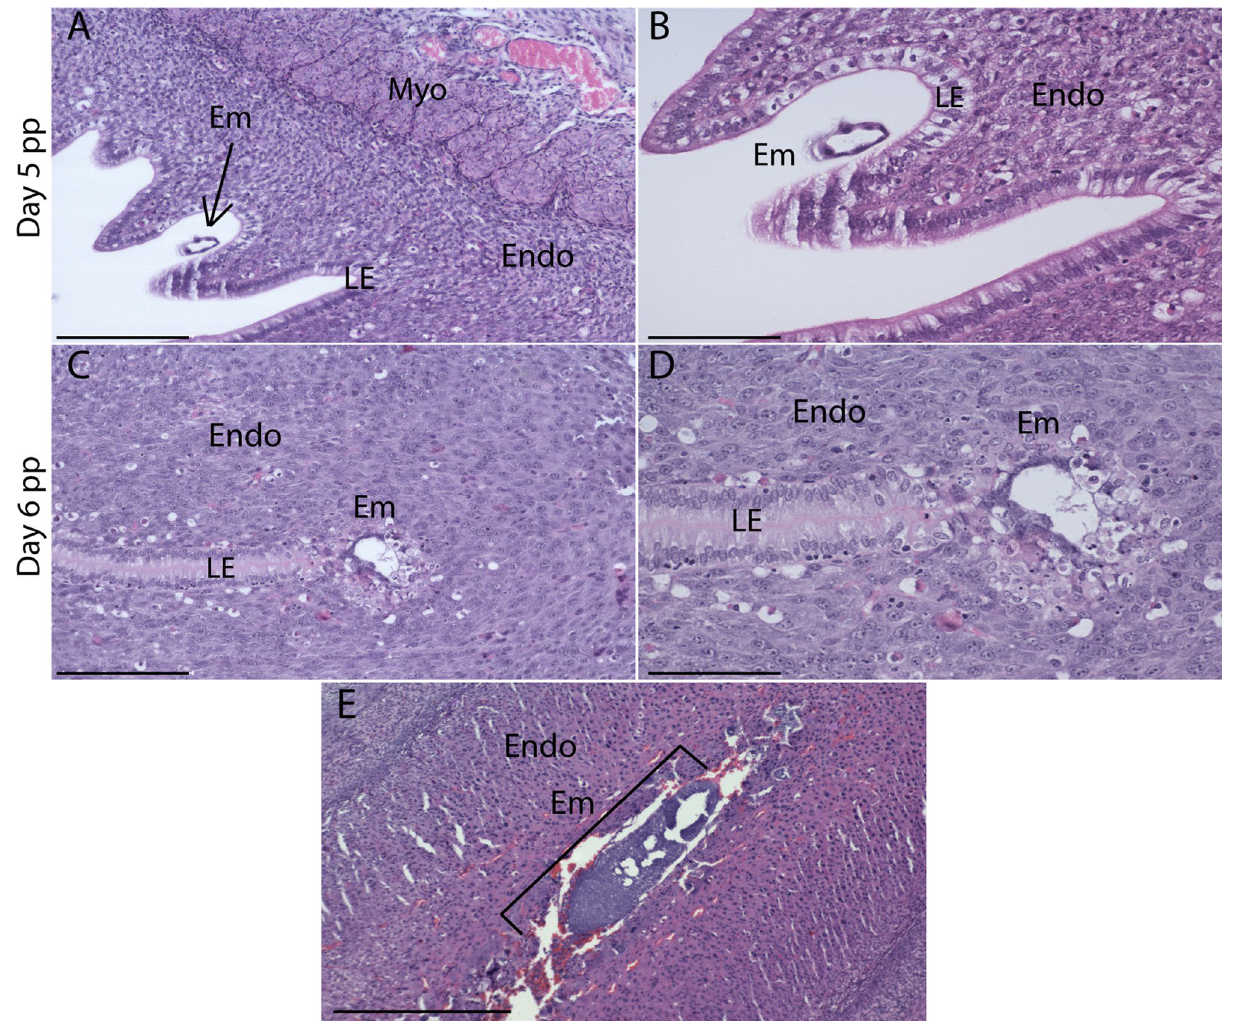
Figure 3. Histological sections of preimplantation embryos and implantation sites in postpartum uteri. Blastocyst (arrow) in the day 4–5 pp uterine lumen apposing sections of luminal epithelium ( A , B ). Embryo implantation sites were seen on day 5–6 pp ( C , D ). A larger, more advanced implantation site is visible in day 10 pp uteri with no remaining epithelium. Scale bars for ( A , C , E ) are 200 μm, and scale bars for ( B , D ) are 100 μm. Luminal epithelium (LE), embryo (Em). Endometrium (Endo), myometrium (Myo), luminal epithelium (LE), embryo